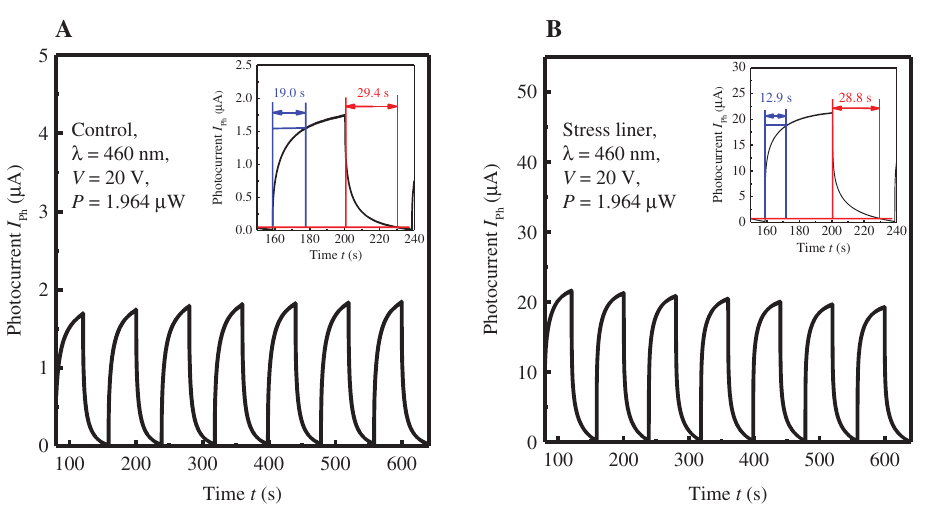
photodetectors with and without stress liner. Figure 5: On/off characteristics of monolayer MoS 2 Photocurrent as a function of time under alternative darkness and illumination. Photocurrent versus time curve of (A) control device and (B) the stress liner device illuminated by 460 nm light source with the incident power of 1.964 μ W at 20 V. The corresponding rise time (from 0% to 90% of maximum photocurrent) and fall time (from 100% to 0% of maximum photocurrent) are shown in the